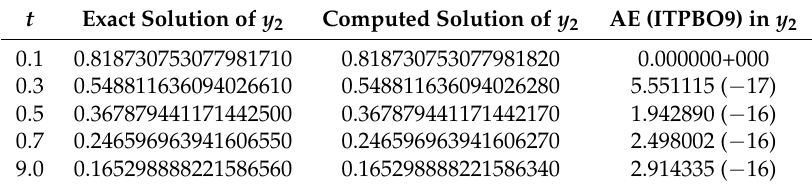
Table 7. Numerical findings for solving y 2 of Problem 4, h = 0.01, t ∈ [ 0,1 ] .